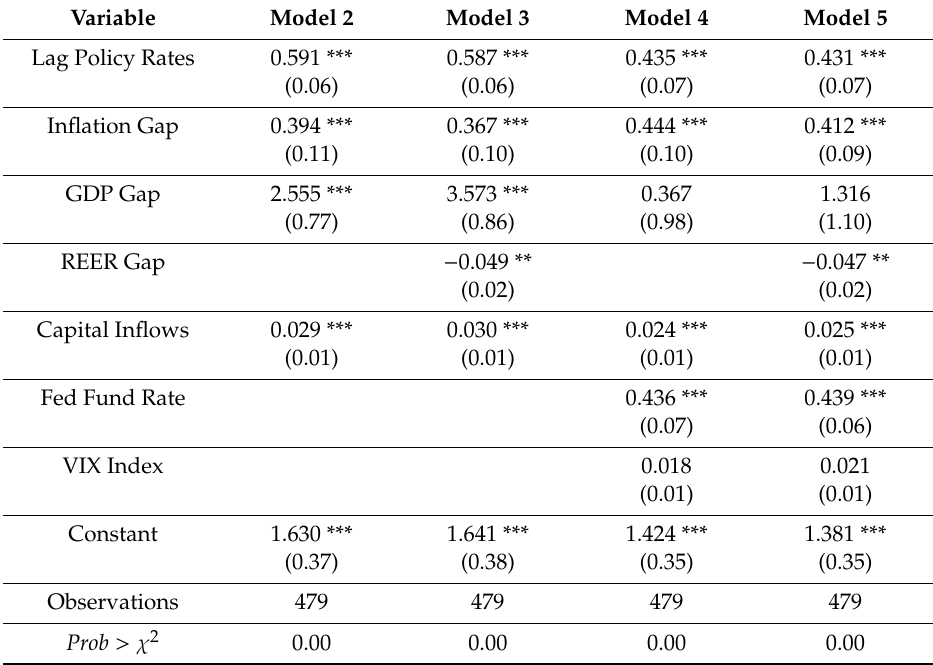
Table 4. The Augmented Taylor Rule with Capital Inflows (without GFC